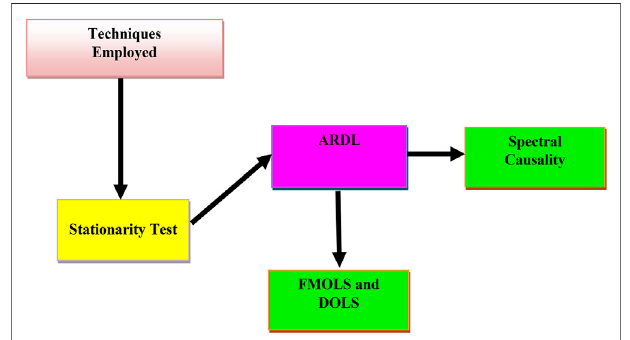
FIGURE 2 | Graphical fl ow of